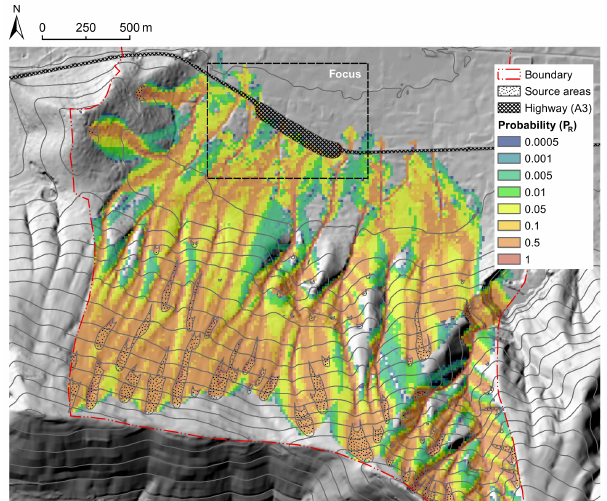
Figure 11. Spatial distribution of reach probability at hillslope scale; the area corresponds to the box named “Mt. Albino” in Fig.